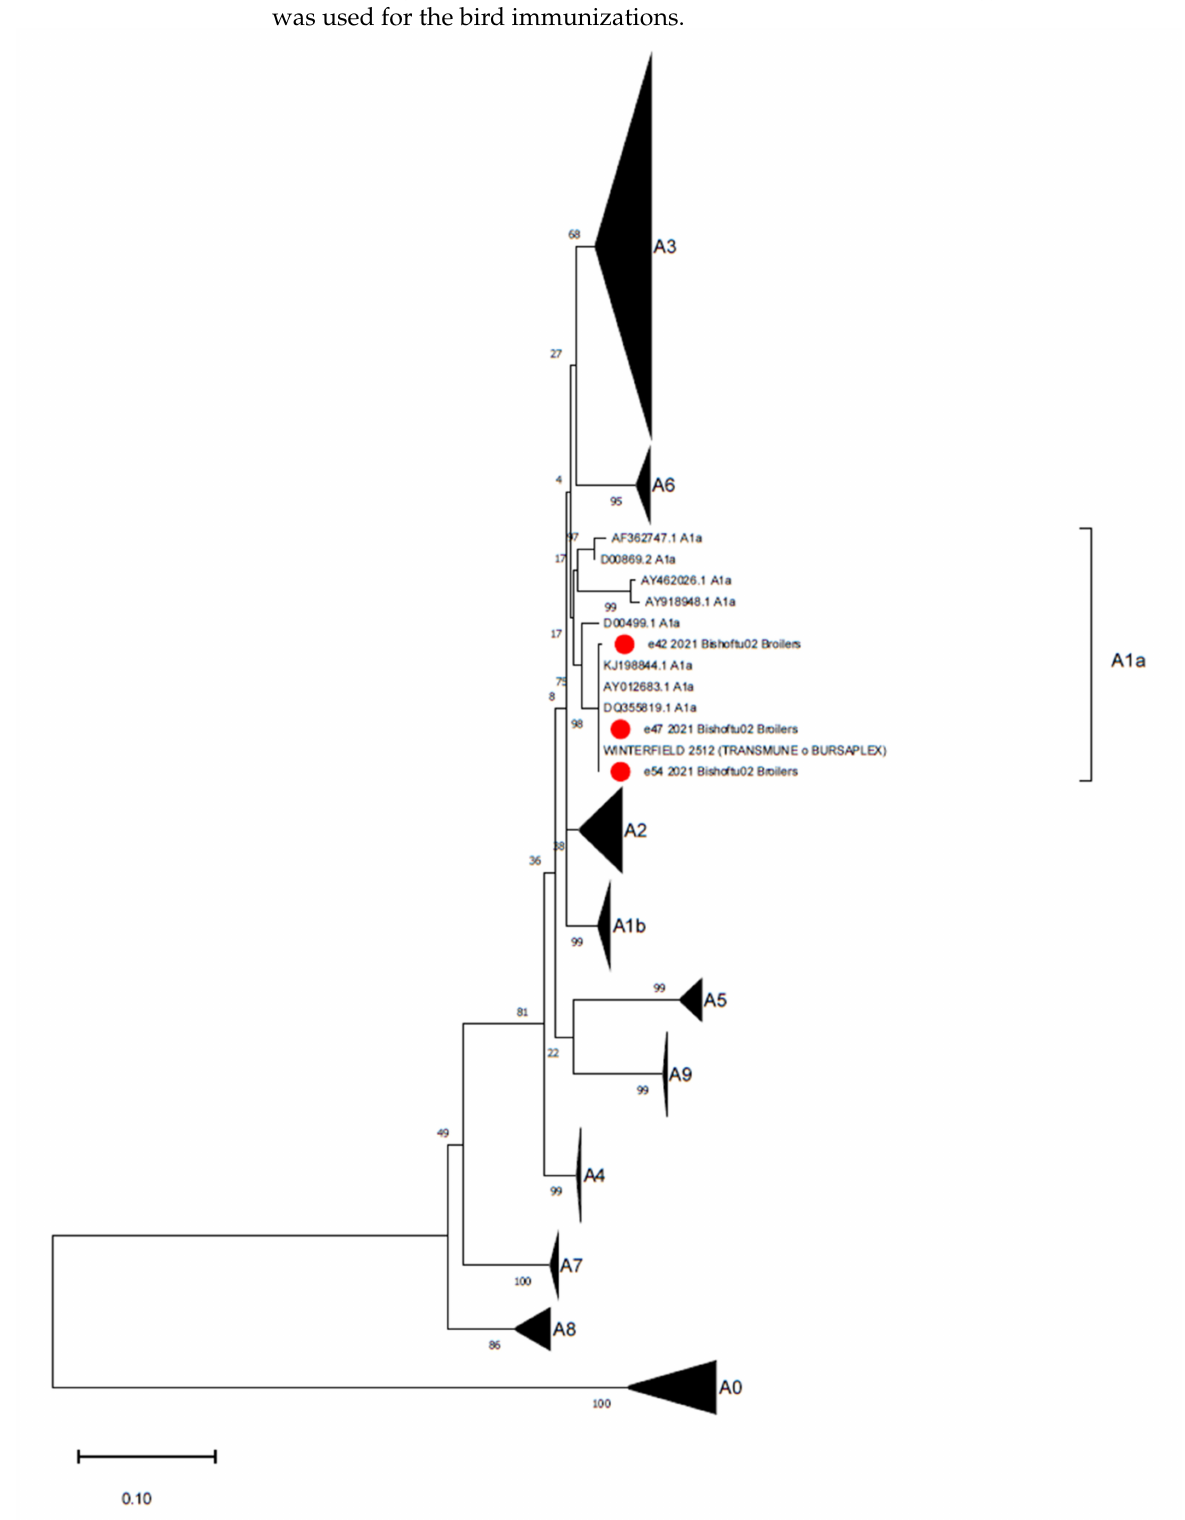
Figure 3. Phylogenetic tree reconstructed for IBDV strain characterization with the database proposed by Islam et al., (2021) [34]. The phylogenetic tree was reconstructed using the Maximum Likelihood method and Kimura 2-parameter model with a discrete Gamma distribution. Branch support is shown next to the branches. The Ethiopian strains are marked with a red